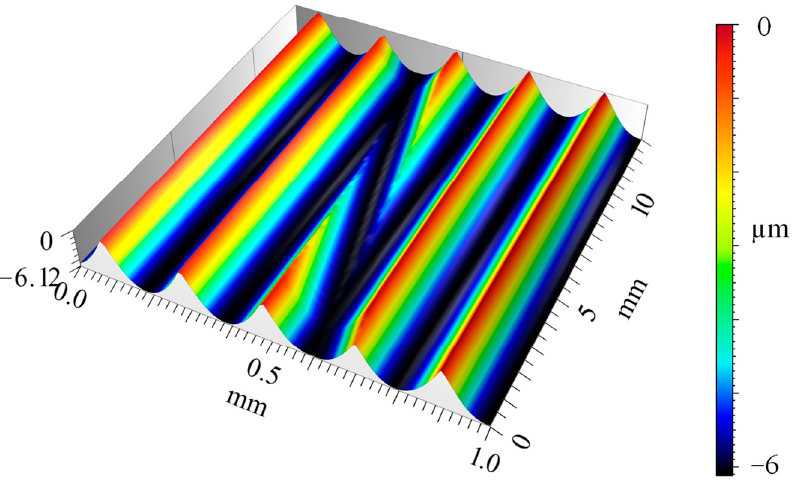
Figure 4. Kinematically simulated transition area.